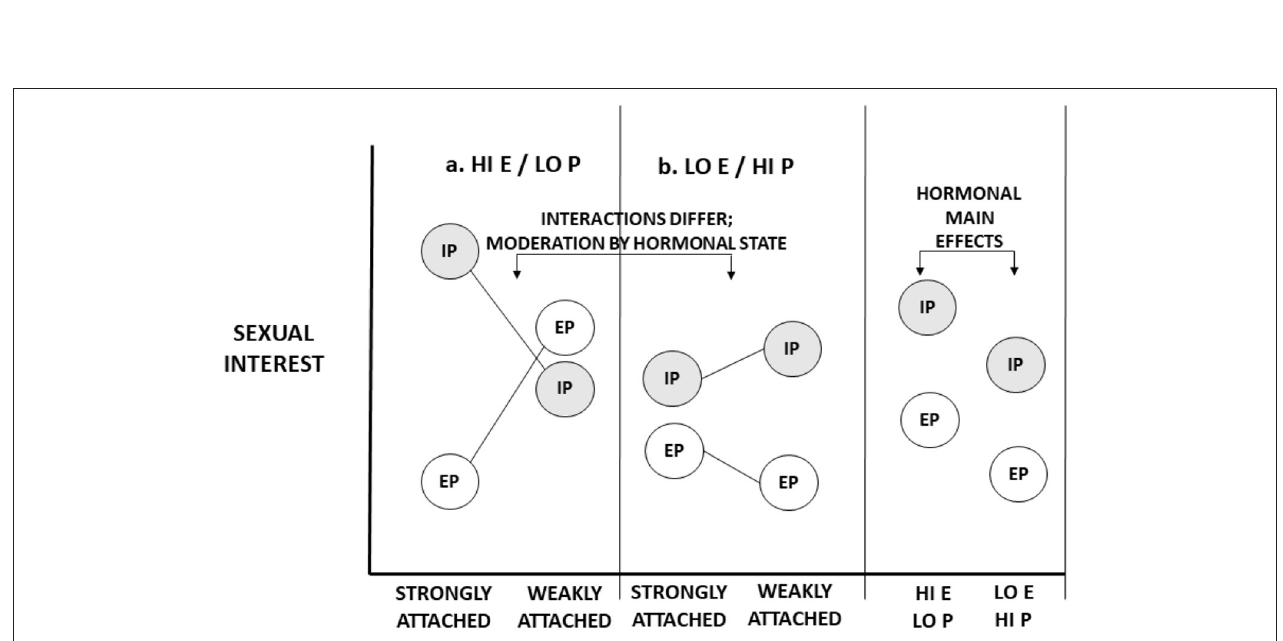
FIGURE 2 | Illustrative representation of the impact of ovarian hormones on the circumstances that evoke sexual interests. Two hormonal states are represented: (a) High levels of estrogen (E) and/or low levels of progesterone (P), characteristic of the conceptive, peri-ovulatory phase; (b) (relatively) low levels of estrogen and high levels of progesterone, characteristic of the non-conceptive, luteal phase of the cycle. Hormonal states moderate the impact of condition (strength of attachment to partners) on in-pair (IP) and extra-pair (EP) sexual interests. The marginal means of hormonal states for both IP and EP sexual interests are not equal—there is an overall main effect of hormonal state in each—but these main effects are qualified by interaction effects.